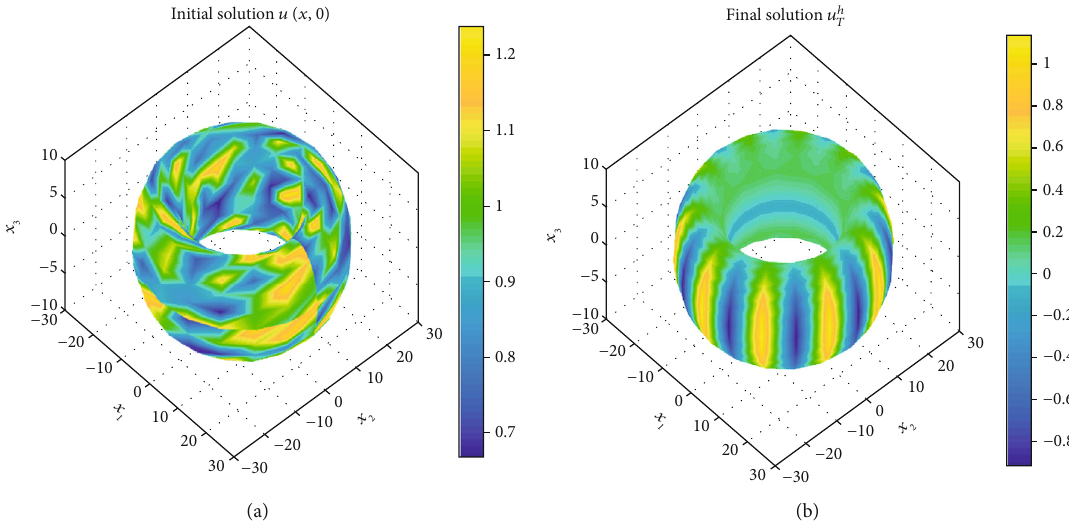
= 1 , D = 1 : 75 , T = 100 , R = 20 , and r = R /3 . v